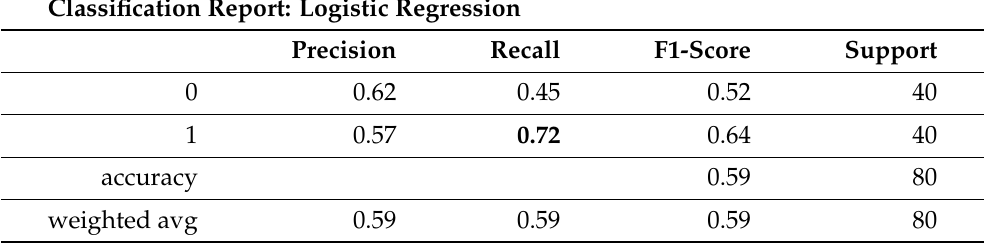
Table 5. Classification report of the logistic regression model and the Gradient Boosting Classifier, generated by TPOT. The numbers in bold represent the highest score in the